Question: What visual encoding does this figure use to show its data?
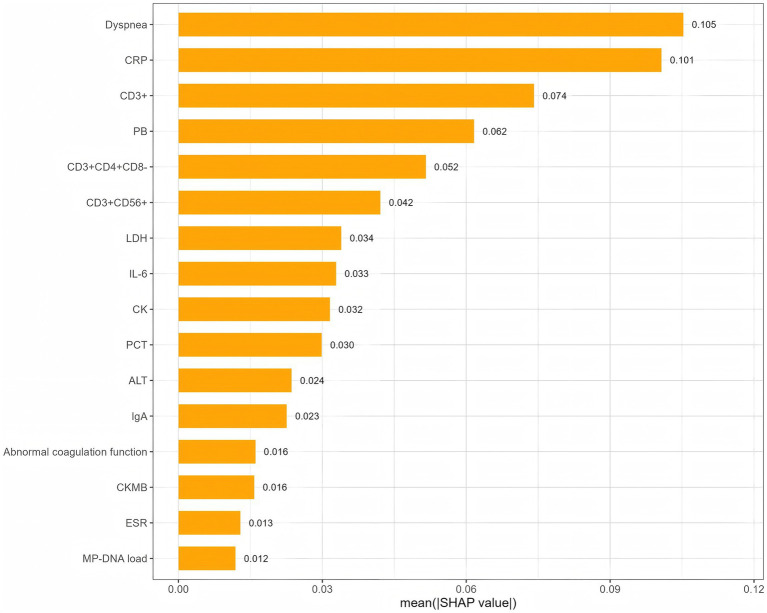
Answer: bar